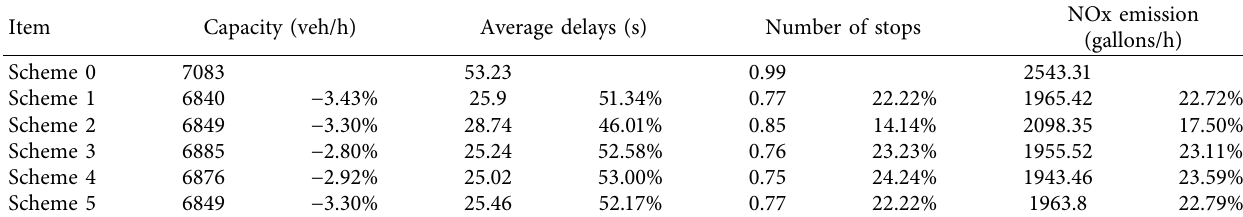
Table 5: VISSIM results of the six selected schemes with evening peak hour